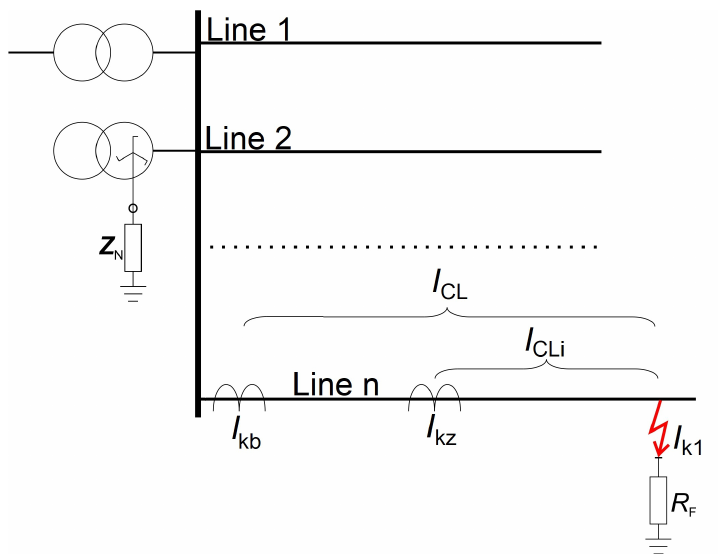
Figure 2. Earth fault current at the fault location and at selected points on the